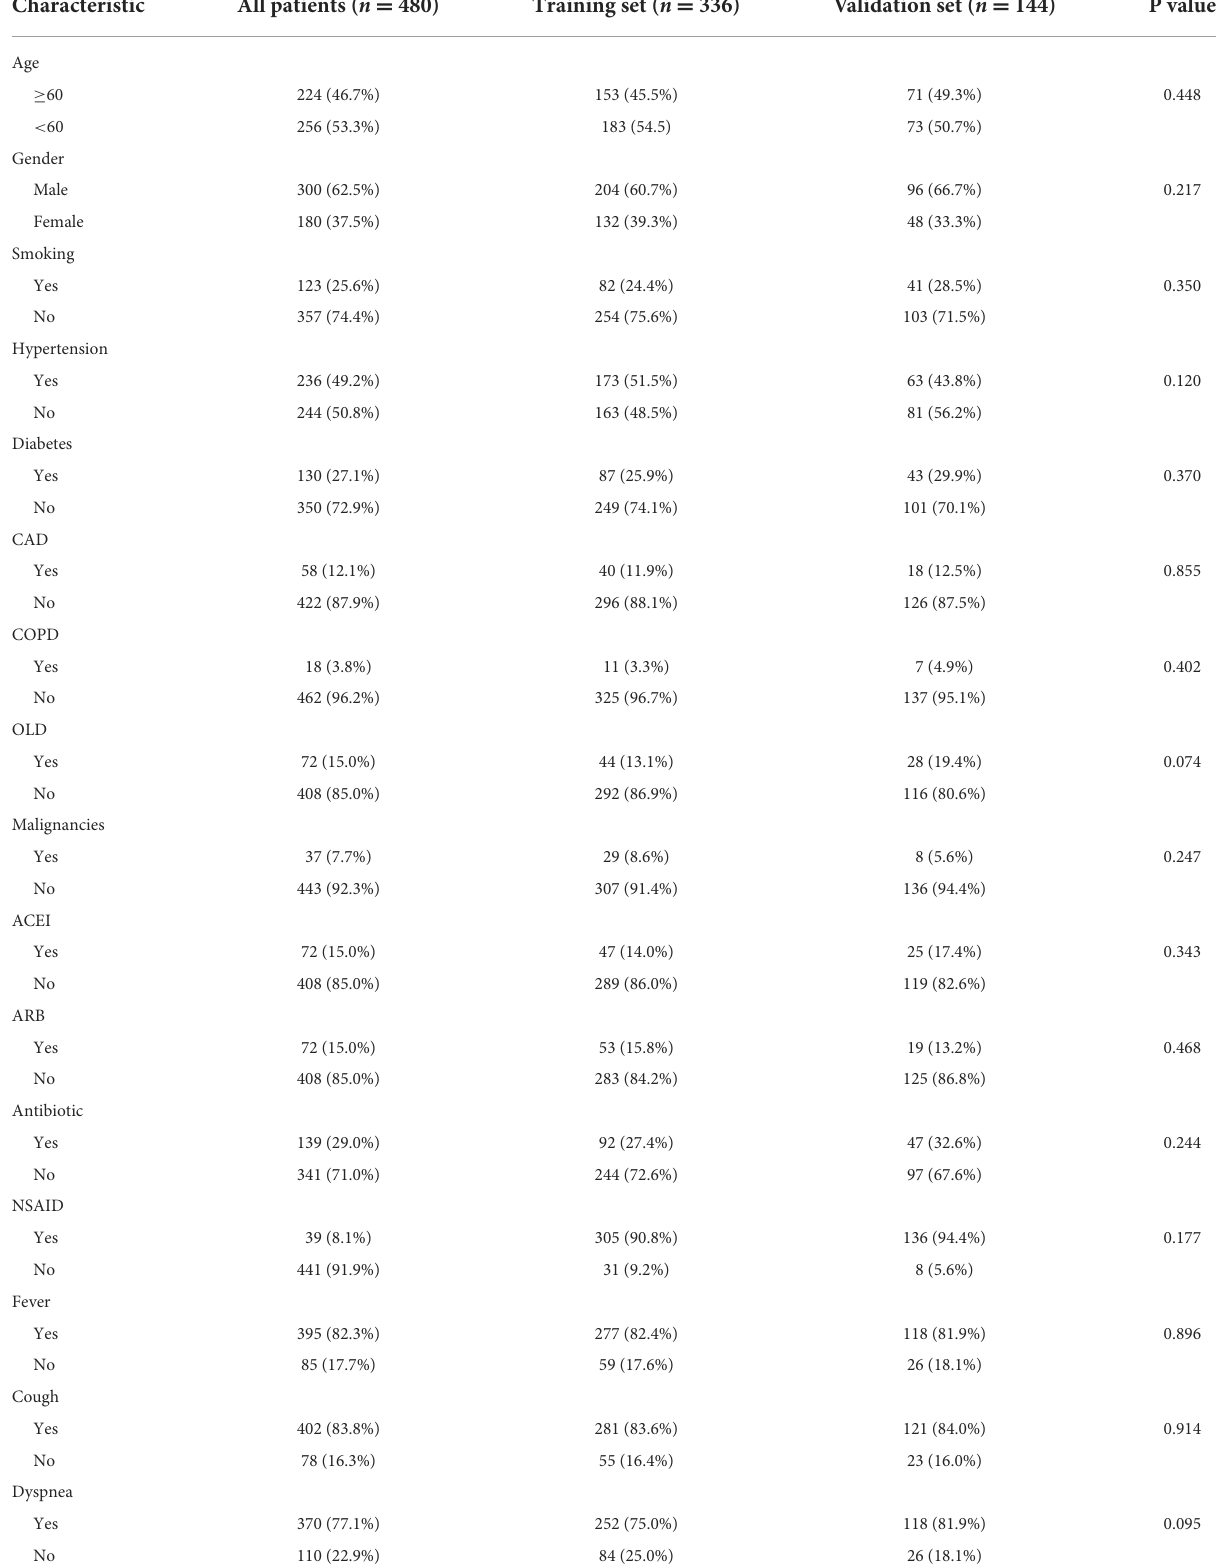
TABLE 1 Baseline characteristics of patients in training set, validation set and all populations.